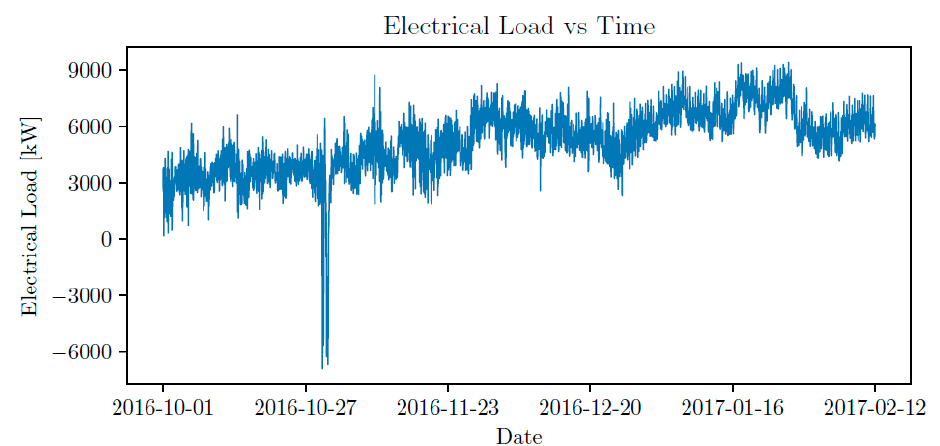
Figure 3. Electrical load measurements.